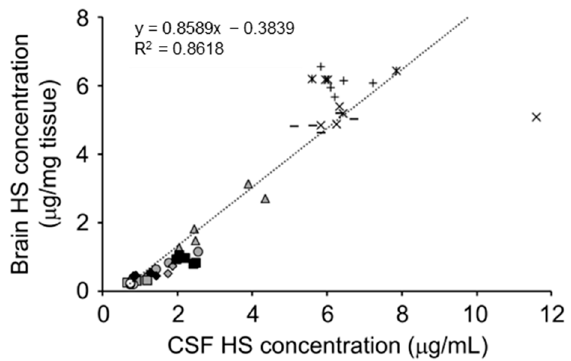
Figure 5. Correlations of heparan sulfate (HS) concentrations between brain and CSF. Values are derived from repeated dose studies of pabinafusp alfa in mucopolysaccharidosis (MPS) II mice [106]. The linear regression equations and correlation coefficients (R 2 ) are shown in the figure. Re- produced from the article by Morimoto et al. [106]. Copyright© 2021 licensed under Creative Com- mons Attribution License (CC BY-NC-ND 4.0).